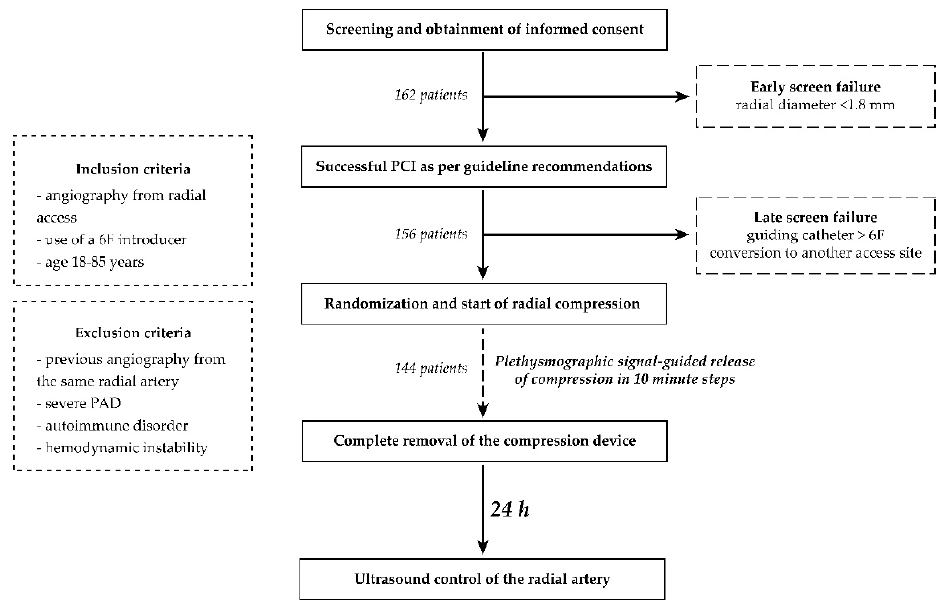
Figure 2. Summary of the study protocol.